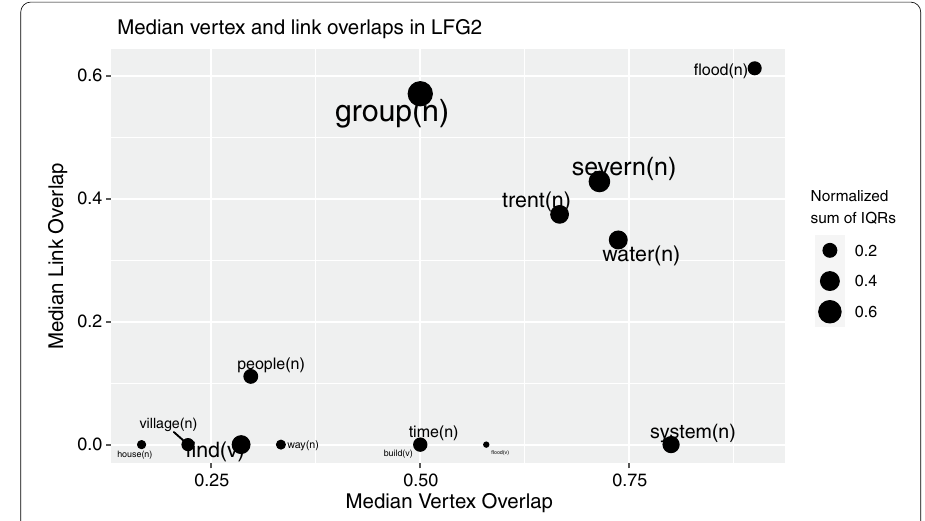
Fig. 14 Median vertex and link overlaps for the actors’ in LFG2. The size of the dot reflects the variability in the concept’s vertex and link overlaps in this location